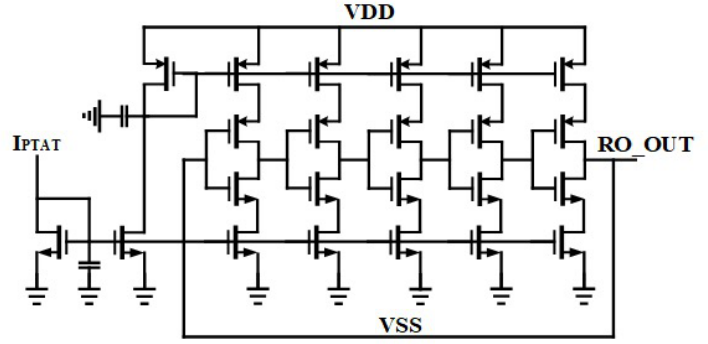
Figure 15. Ring oscillator